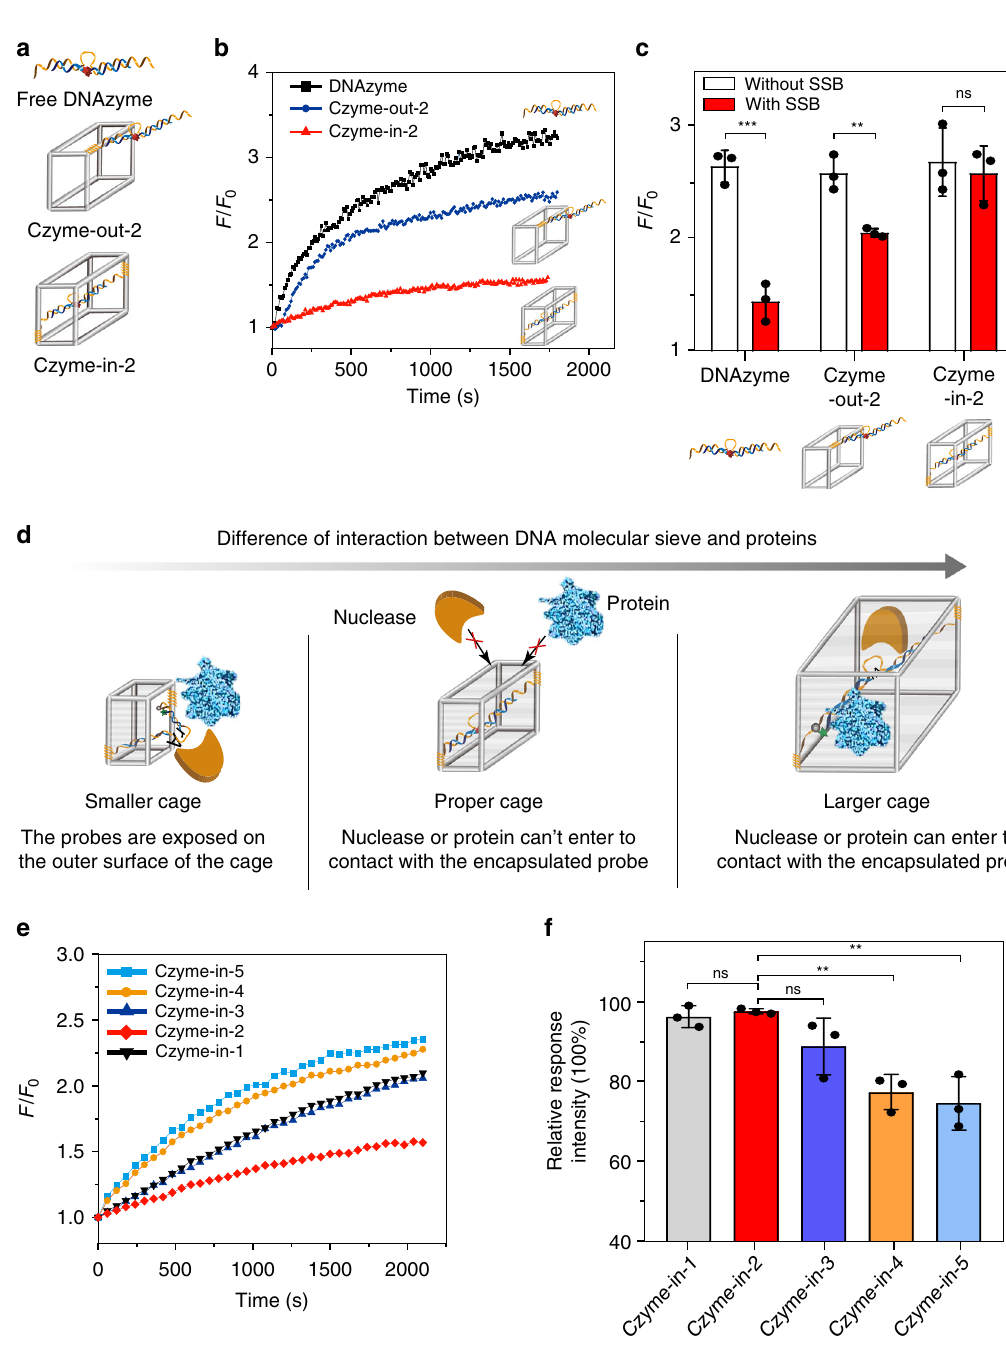
Fig. 4 The size-dependence protective performance of DNAzyme encapsulated in the DNA nanocages. a Schematic illustration of three kinds of DNAzyme probes: free DNAzyme, DNAzyme connected to the outside frame of Cage 2 (Czyme-out-2), and DNAzyme encapsulated inside Cage 2 (Czyme-in-2). b Time-dependent fl uorescence changes of different probes after the addition of nuclease (F 0 fl uorescence intensity without DNase I, F fl uorescence intensity with DNase I). c Fluorescence response of free DNAzyme, Czyme-out-2 and Czyme-in-2 to L -histidine treated with and without SSB (F 0 fl uorescence intensity without L -histidine, F fl uorescence intensity with L -histidine); Data are presented as mean values ± s.d. ( n = 3); *** p = 0.00070 < 0.001, ** p = 0.0046< 0.01, ns = 0.6800> 0.05 (not signi fi cant), by two-tailed unpaired Student ’ s t -test. d Schematic illustration of the cavity effect; e Time-dependent fl uorescence changes of different cage sizes after the addition of nuclease (F 0 fl uorescence intensity without DNase I, F fl uorescence intensity with DNase I). f Relative response intensity of different cage sizes to L -histidine after treatment with single-strand binding protein (SSB) ( “ Relative response intensity ” refer to the ratio of (F/F 0 ) with and without SSB; F: fl uorescence intensity with L -histidine, F 0 fl uorescence intensity without L -histidine); Data are presented as mean values ± s.d. ( n = 3); ** p = 0.0014 (0.0040) for Czyme-in-4 (Czyme-in-5) < 0.01, ns = 0.43 (0.10) for Czyme-in-1 (Czyme- in-3) > 0.05 (not signi fi cant), by two-tailed unpaired Student ’ s t -test. Source data are provided as a Source Data fi